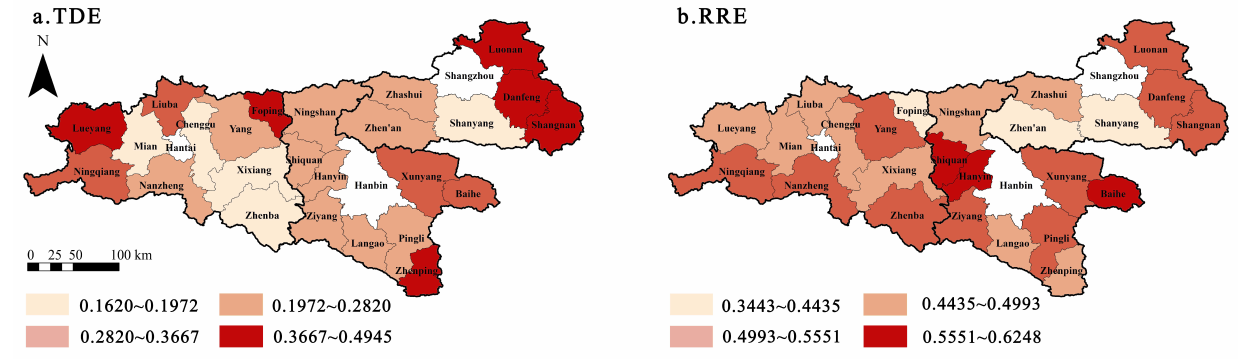
Figure 6. Distribution map of TDE and